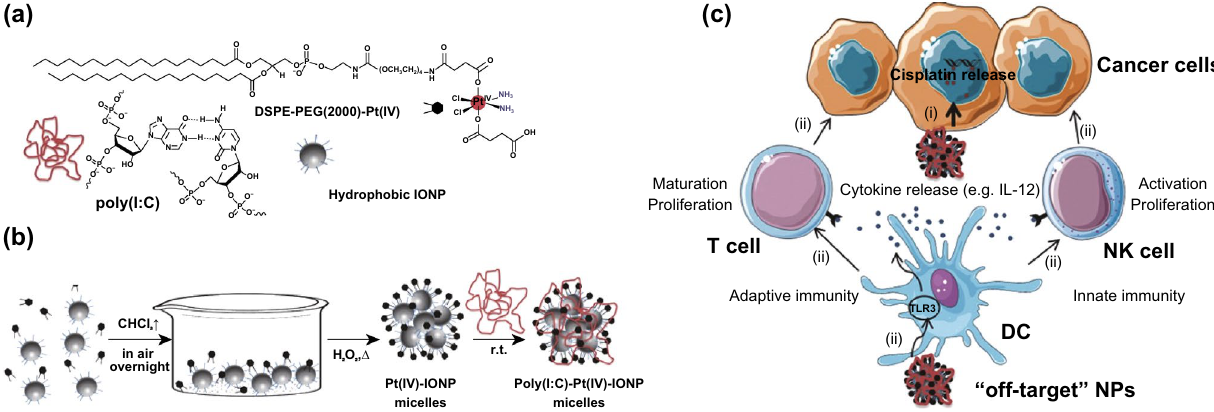
Fig. 4 Preparation of the poly (I:C)–Pt(IV)–IONP micelles. a Structure and schematic representation of the reaction components and b sche- matic of the simple self-assembly procedure used to prepare the Pt(IV)–IONP micelles and poly (I:C)–Pt(IV)–IONP micelles (not to scale). c Schematic illustration of the combination therapeutic effect of poly (I:C)-Pt(IV)-IONPs. Reproduced with permission from Ref. [108]. Copy- right 2015 John Wiley and